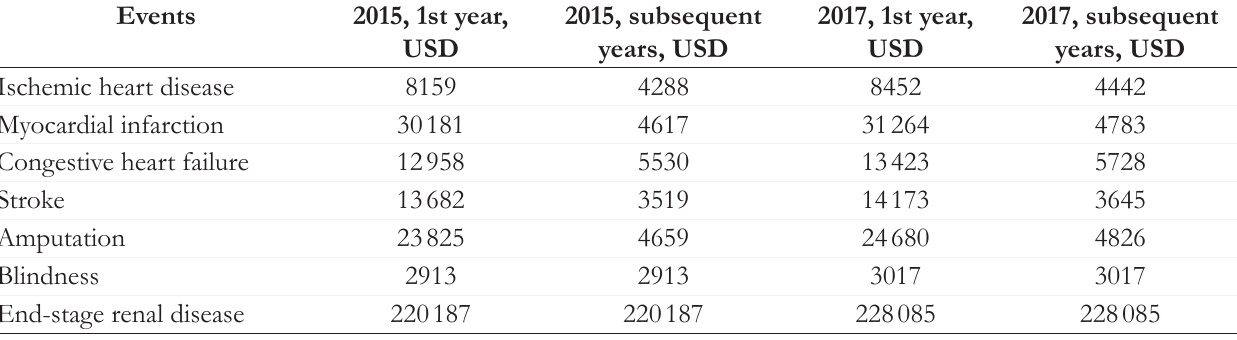
Table 3. Cost of Complications from T2D Used in the Model Inflated to August